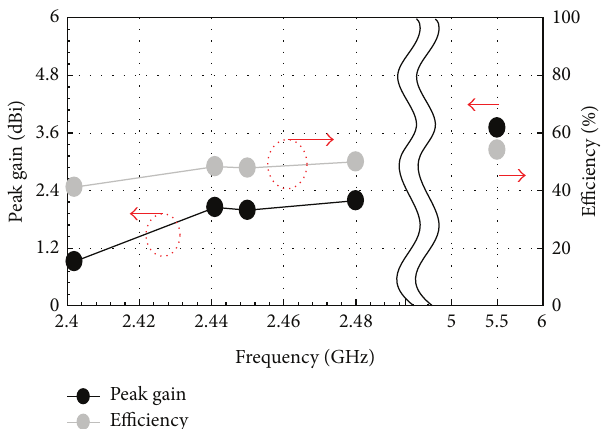
Figure 12: The simulated peak gain and efficiency for proposed